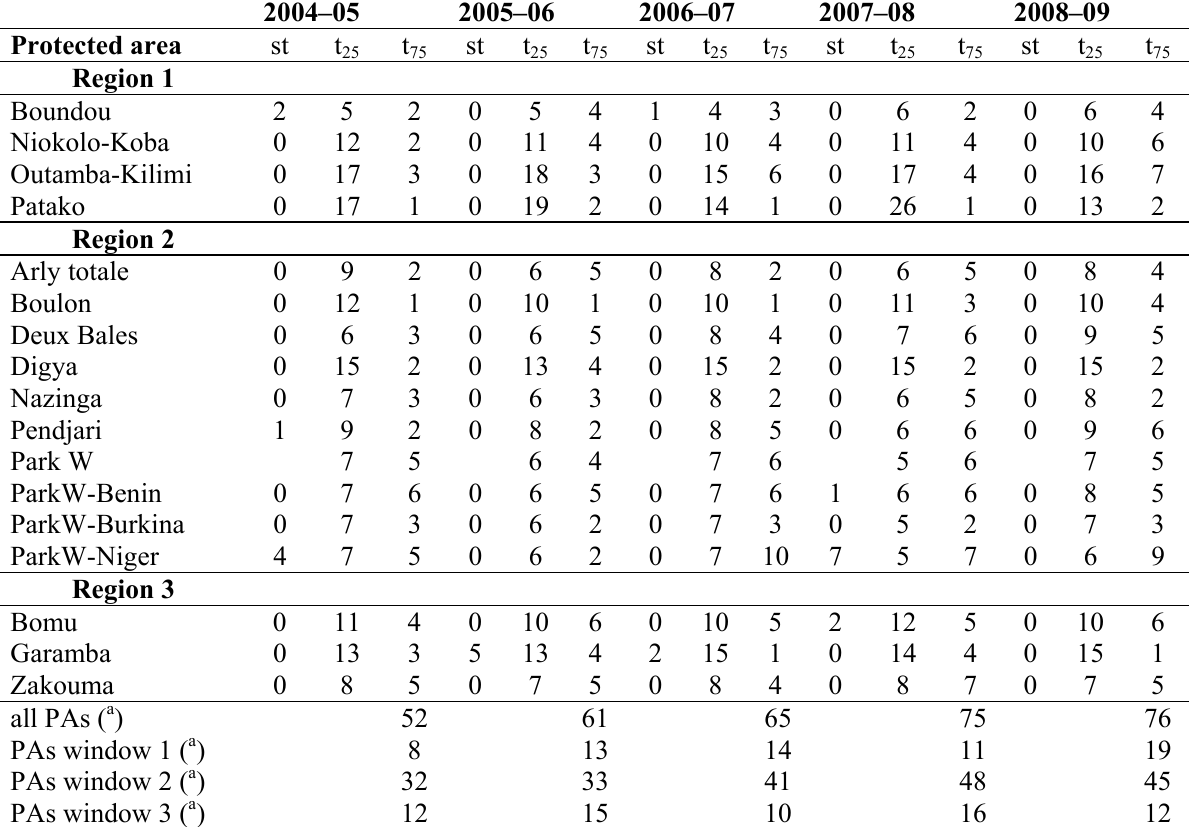
Table 2. Fire seasonality for the 2004-09 period. st: number of fire pixels detected during the 1 st week of October. t : number of weeks, since 1 st of Oct., to reach 25% of the 25 : number of weeks between the 1st quartile (25%) and the 4th seasonal total. t 75 quartile